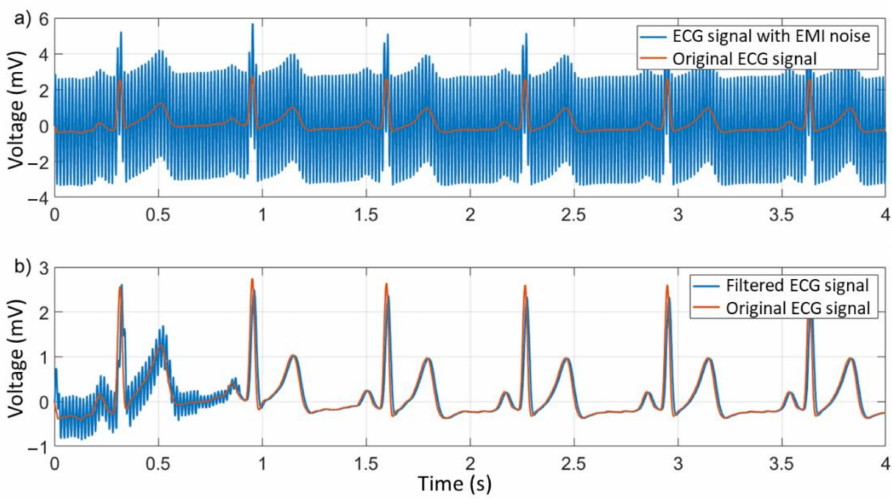
Figure 16. ECG signal with EMI noise, original ECG ( a ), and filtered ECG ( b ).